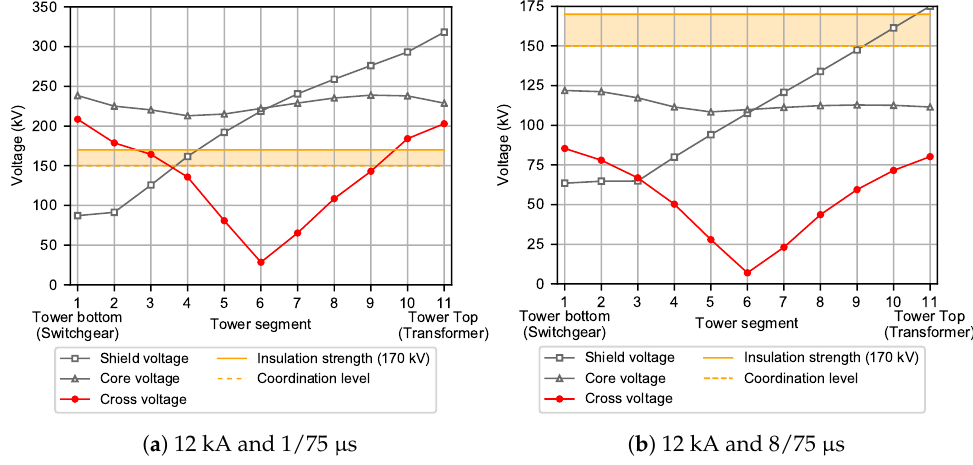
Figure 8. Overvoltage amplitudes distribution across the power cable with upward lightning